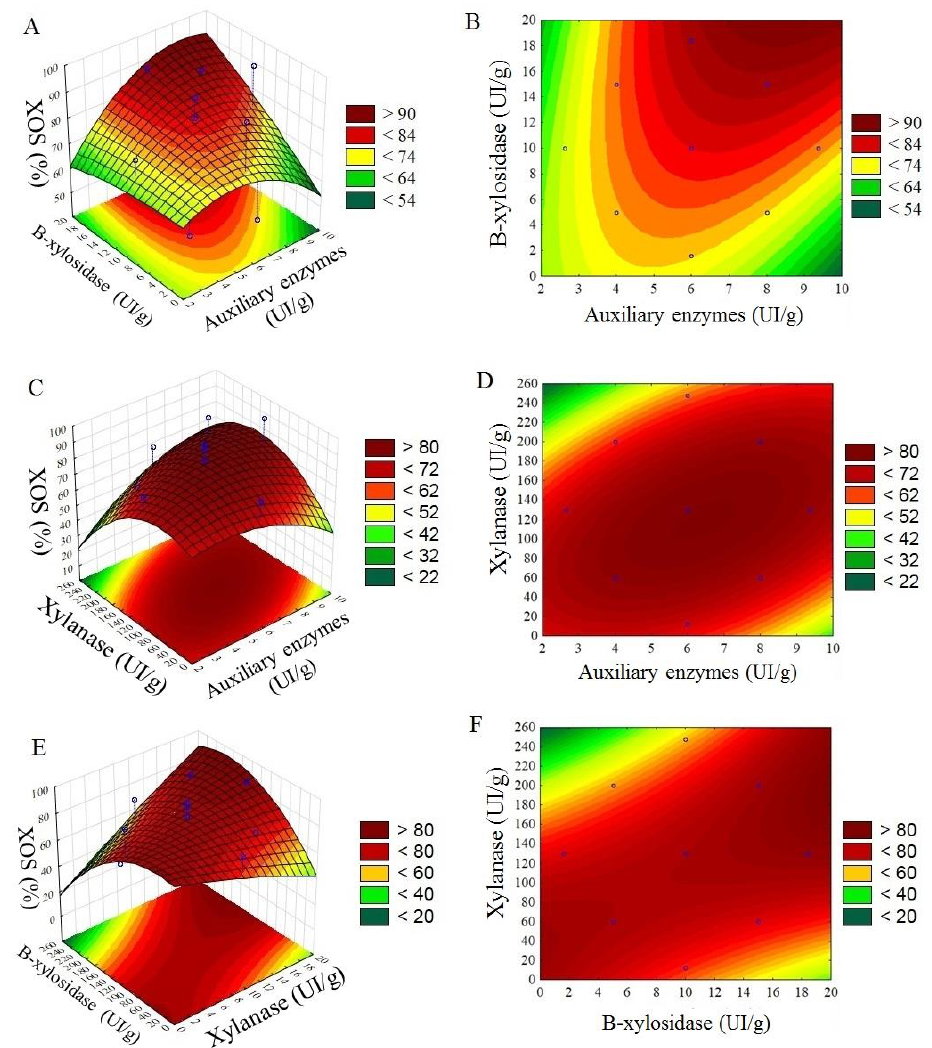
Figure 2. Response surface of xylooligosaccharides yield (%) to experimental design to obtain complete hydrolysis of xylan using xylanase (IU/g), β -xylosidase (IU/g), and auxiliary enzymes (IU/g) variables. ( A , B ) β -xylosidase (IU/g) and auxiliary enzymes (IU/g) variables; ( C , D ) xylanase (IU/g) and auxiliary enzymes (IU/g) variables; ( E , F ) xylanase (IU/g) and β -xylosidase (IU/g) variables.